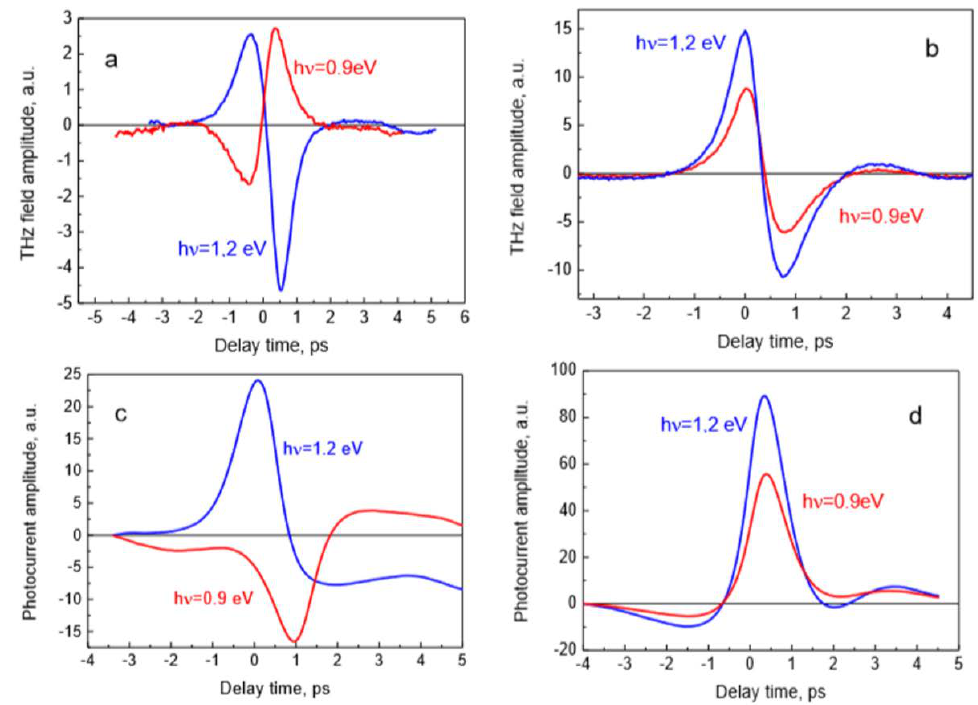
Figure 2. THz electric field ( a , b ) and photocurrent ( c , d ) pulses measured at two different optical wavelength beams impinging on sample A from the InP substrate side ( a , c ) and from the GaInAs epitaxial layer side ( b , d ).